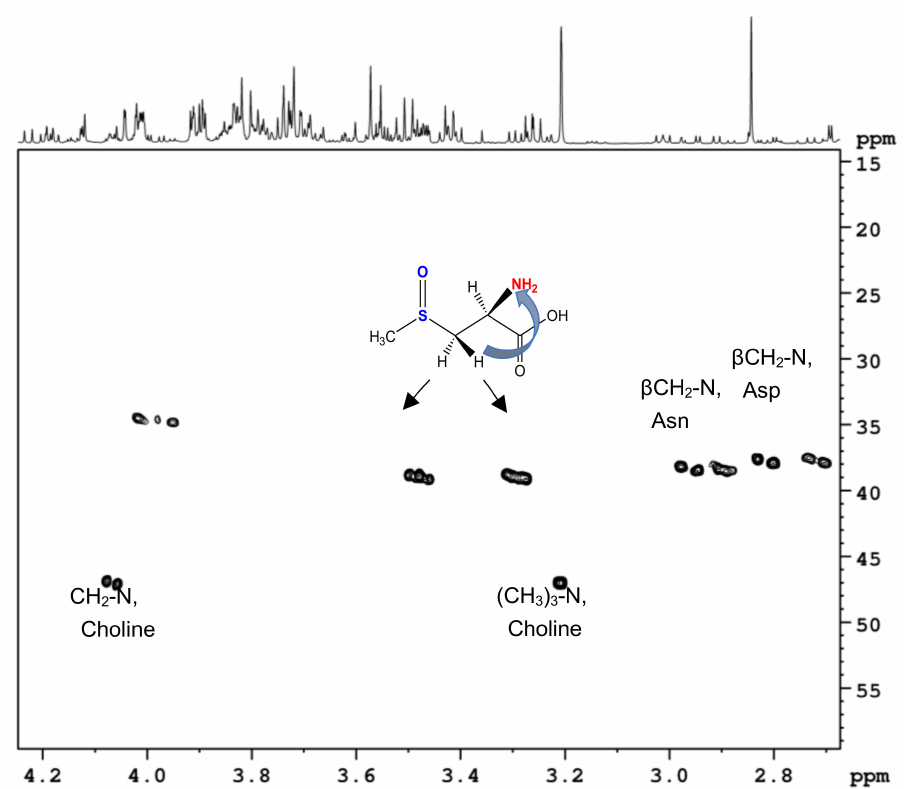
Figure 4. Selected region of 1 H- 15 N HMBC NMR spectrum of cauliflower water-soluble metabolite fraction (florets